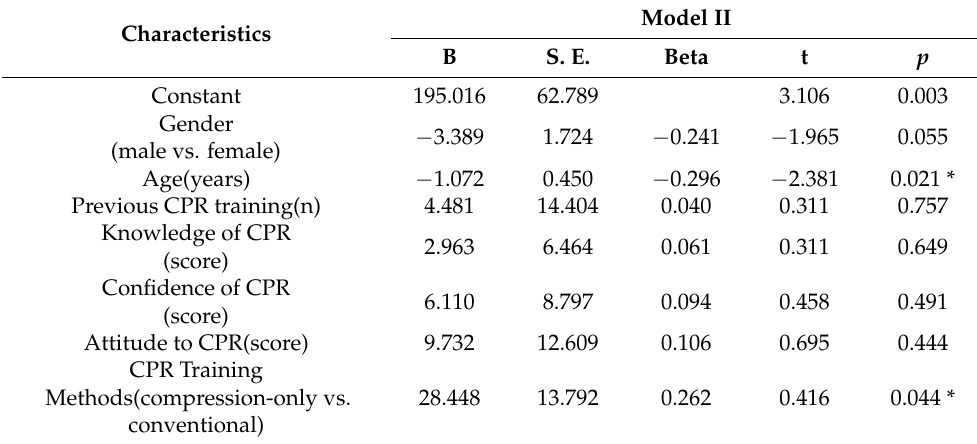
Table 5. The effects of participants’ characteristics on the accuracy of CPR skills at 3 months after training. Model II Characteristics B S. E. Beta